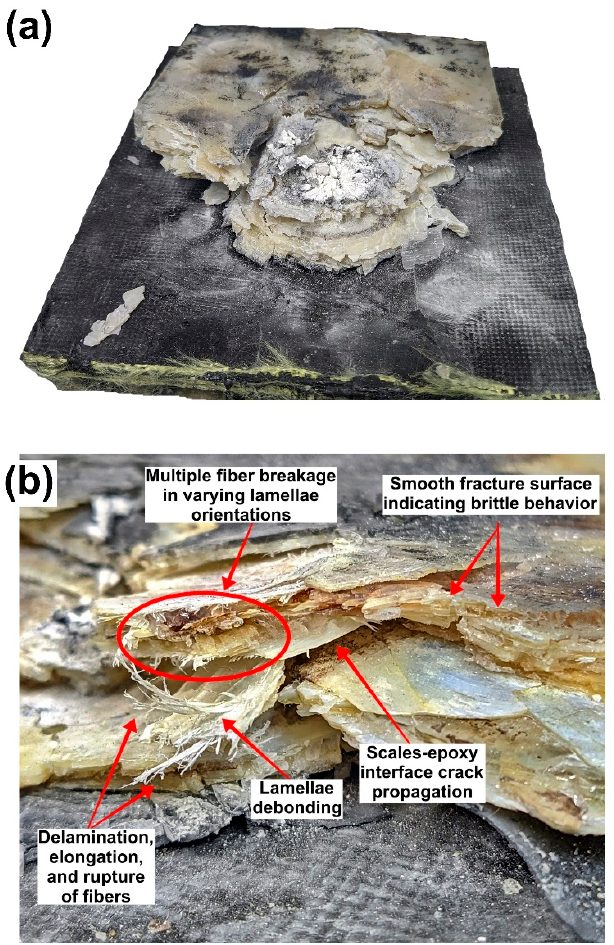
Figure 11. Macroscopic aspect of the MAS using arapaima scales-epoxy composites as the intermediate layer: ( a ) ceramic fragments arrested by the composite plate, and fracture of plate into different pieces; ( b ) energy absorption mechanisms in the arapaima scales-epoxy composites.